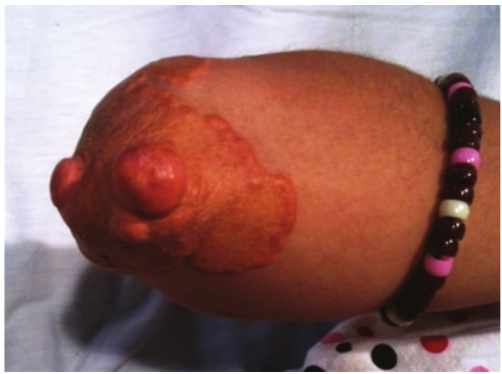
Figure 1: Cutaneous xanthomas on the left elbow of patient no. 2.